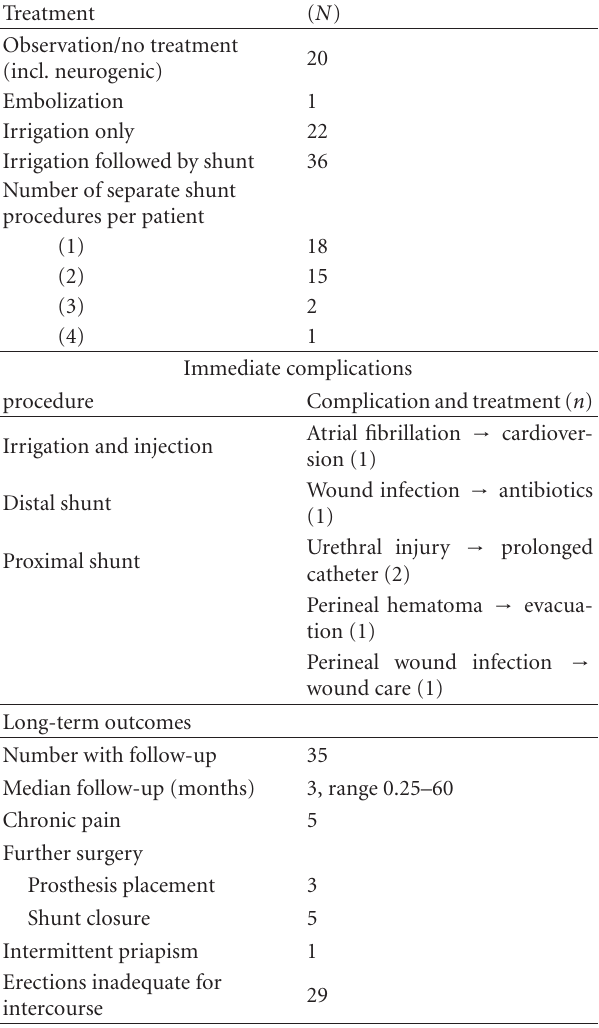
Table 3: Priapism treatments and